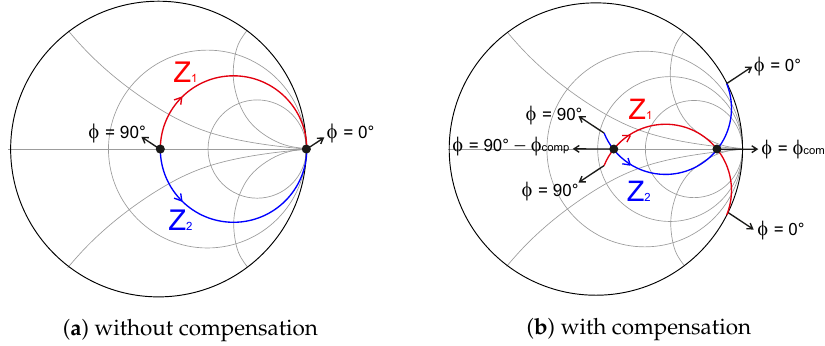
Figure 12. Load trajectories of the upper (red) and lower (blue) branches for a phase sweep from 0 ◦ –90 ◦